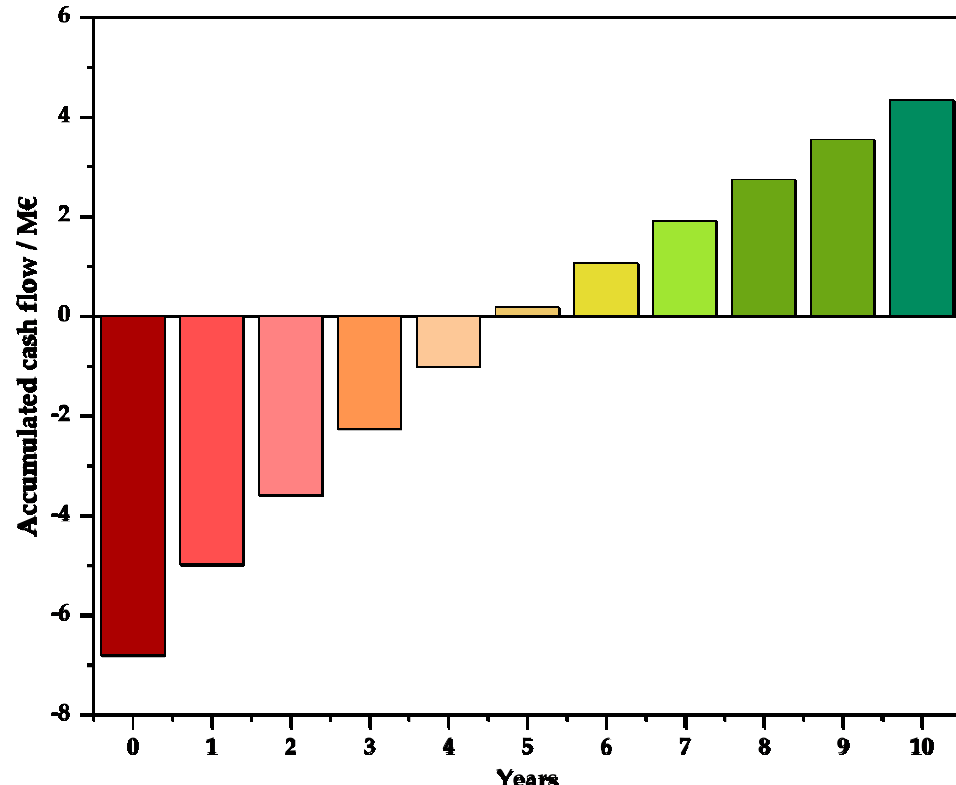
Figure 2. Cumulative cash flows for the multi-product biorefinery concept in current prices.